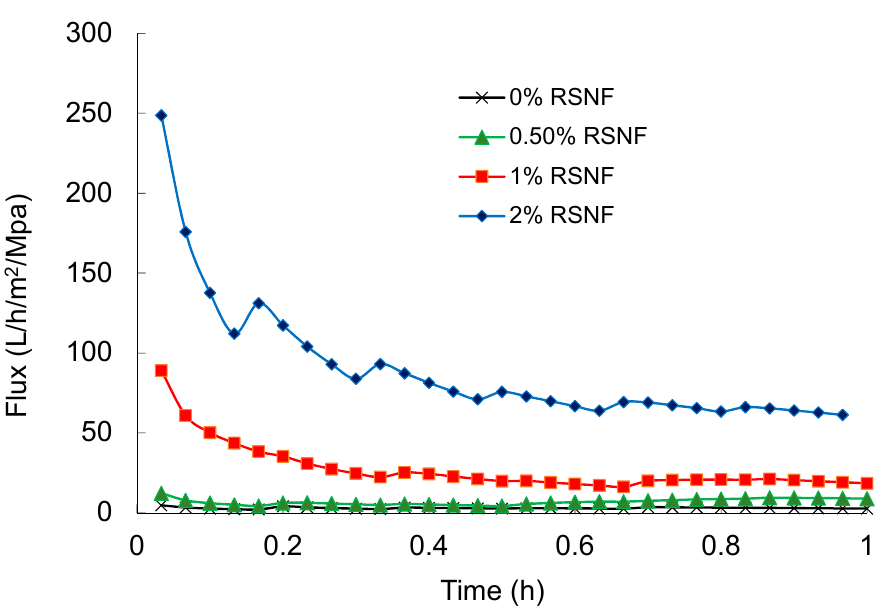
Figure 6. Fouling of PSF and PSF/RSNF membranes with different loadings of RSNF when passing 1% bovine albumin solution.